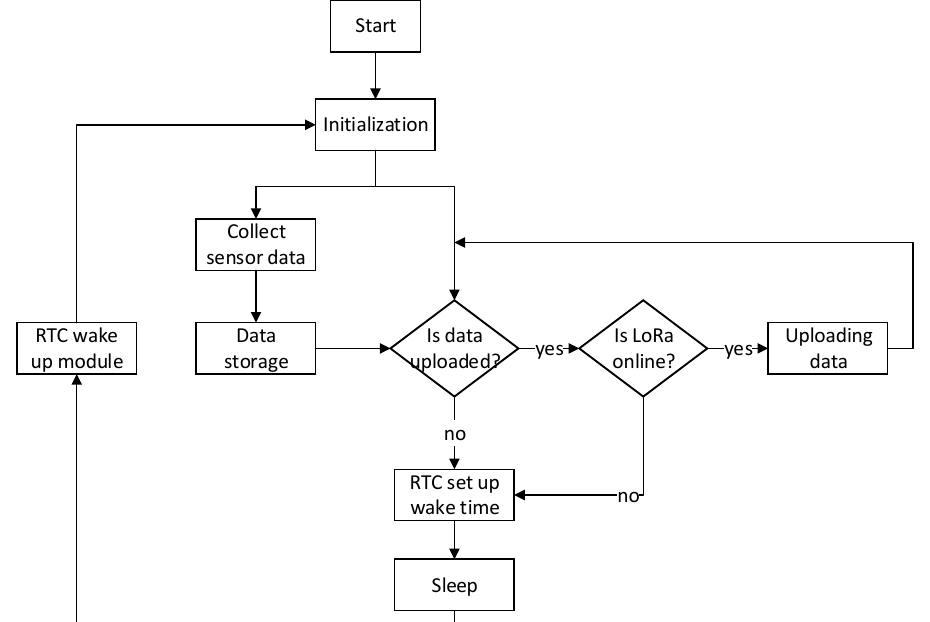
Figure 5. The embedded platform software flow that is applied to the main board of LoRa acquisition equipment. It shows the processing of an acquisition task. RTC = real time clock.